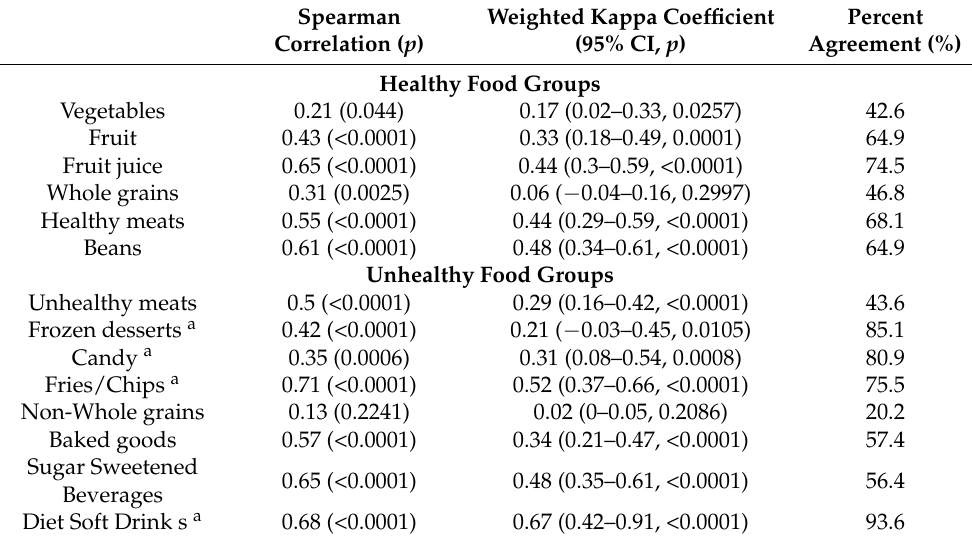
Table 4. Comparison of SPAN MAA and 24 h recall (n = 94).